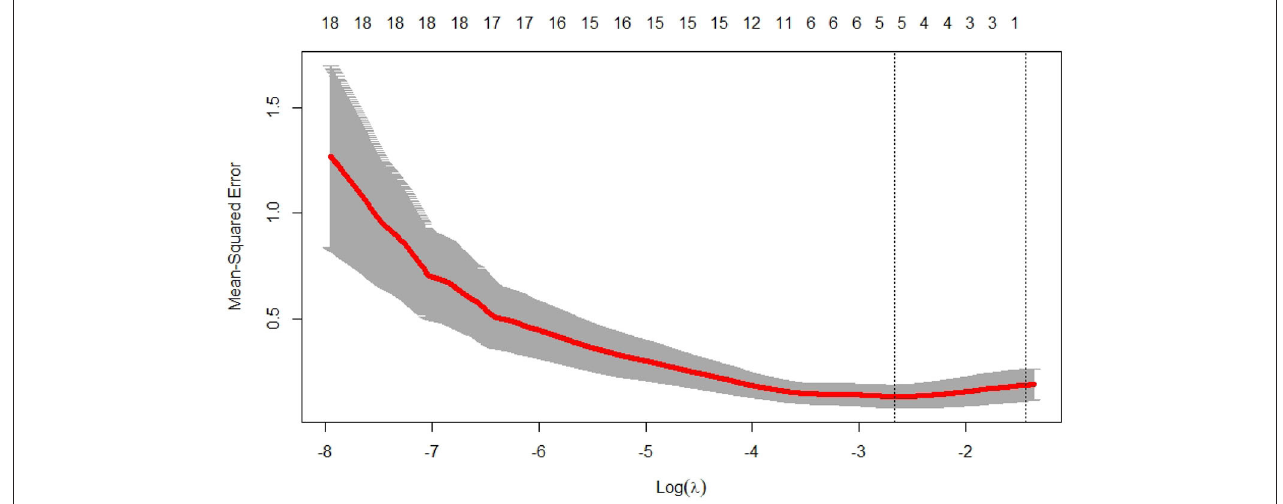
FIGURE 5 | Lasso regression analysis number of iterations vs. mean square error. It shows that the optimal λ value is obtained in 5th